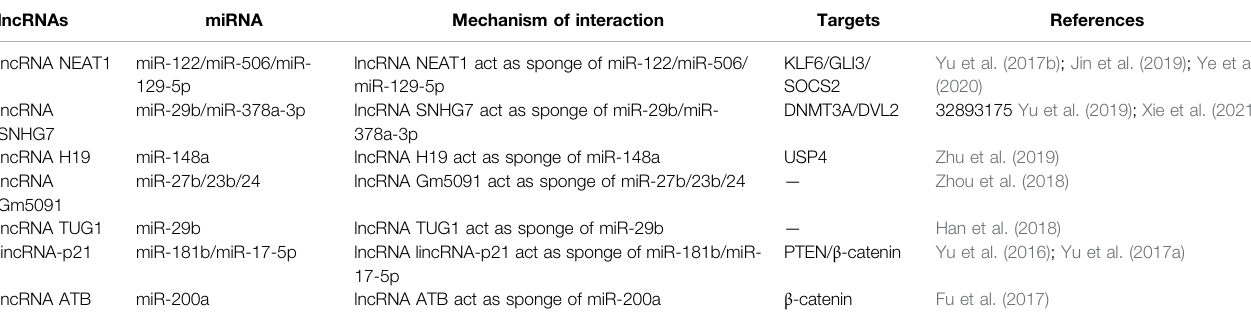
TABLE 2 | lncRNA as ceRNA in liver fi